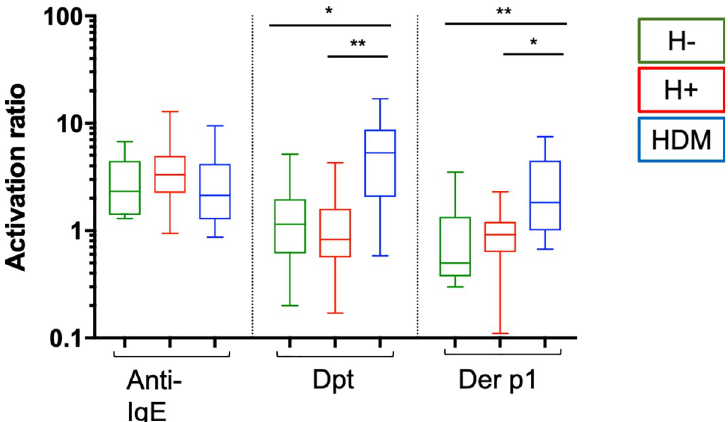
Fig 3. Mast cell activation after passive sensitization. The activation ratio (AR) calculated between CD63 (%) after anti-IgE, Dpt ( Dermatophagoides extract), Der p1 stimulation, and negative control. H-: non-infected group (green, n = 11), H+: helminth-infected group (red, n = 18), HDM: subjects allergic to house dust mites (blue, n = 12). � p < 0.05, �� p < 0.01, ��� p < 0.001, Kruskal-Wallis test with corrected Dunn’s test.